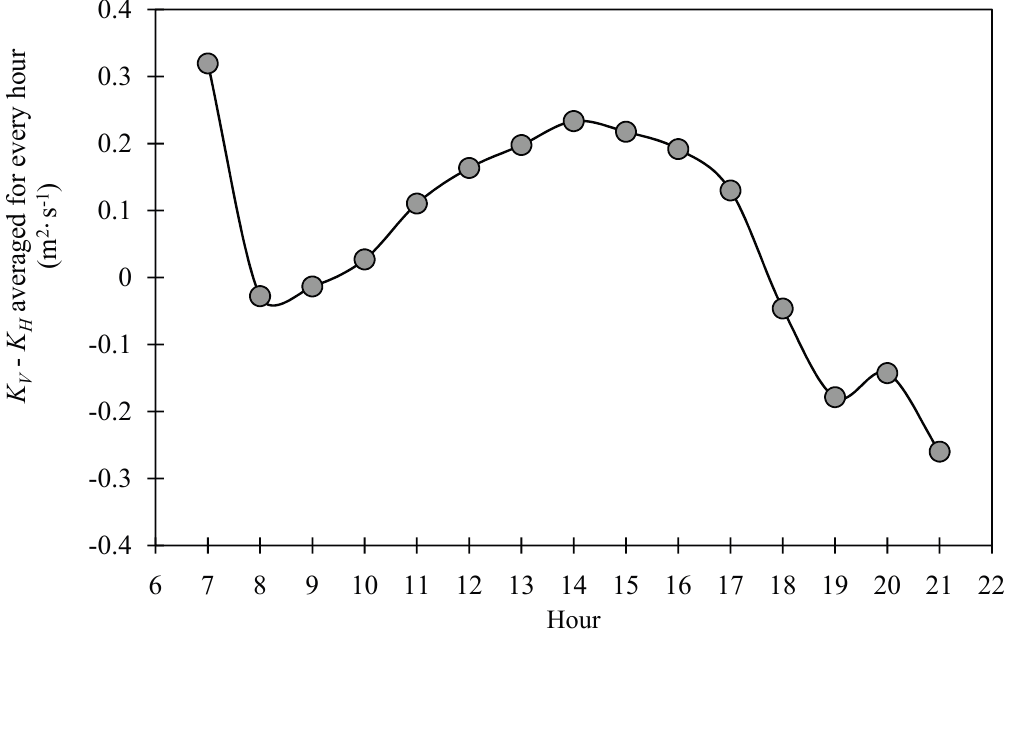
Figure 6. Average of the diurnal variations of K 07:00 to 21:00. The K during the 2005 and 2006 growing and non-growing (dormant)